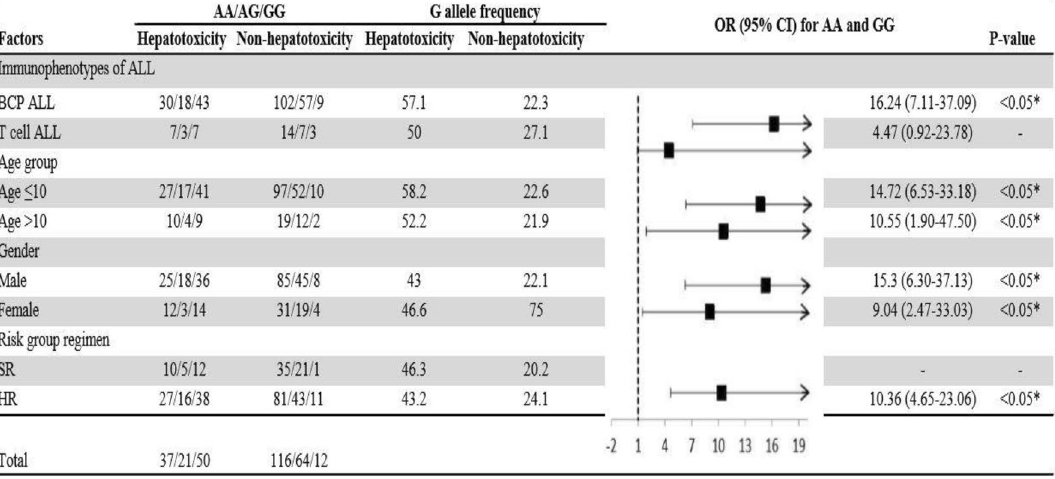
Figure 1. Adjusted association between SOD2 (rs4880) genotypes and risk of hepatotoxicity.